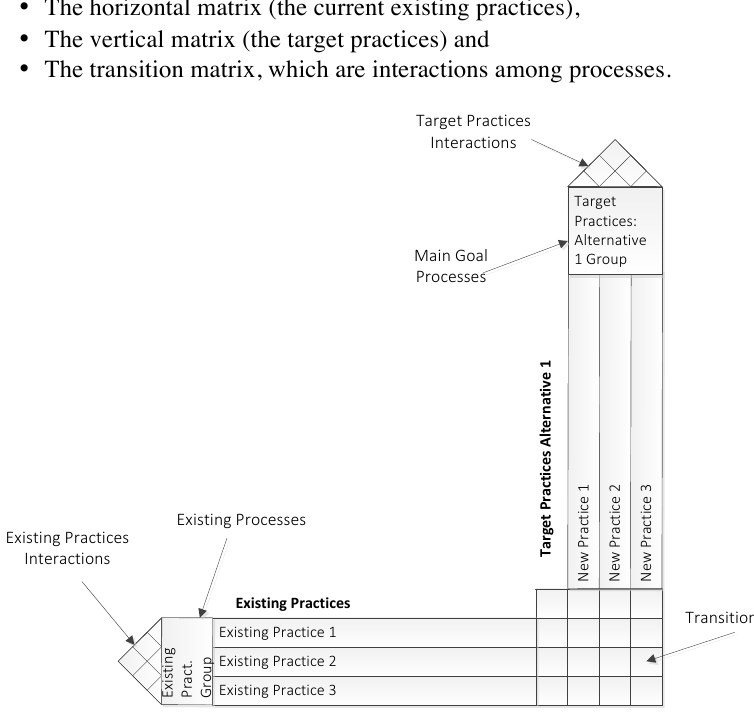
Fig. 3. Matrix of Change (MOC) (Elattar,